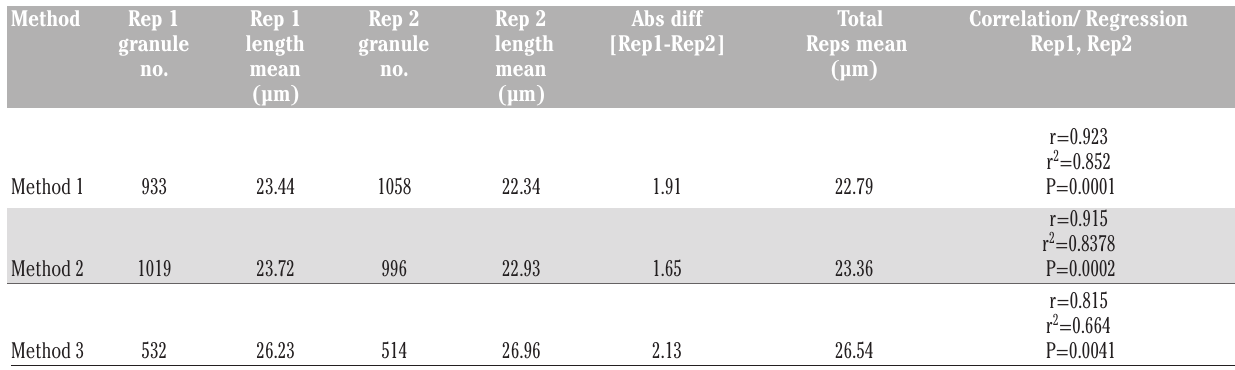
Table 4. Means of all the measurable starch granules and the reproducibility between repeated experiments. a Method